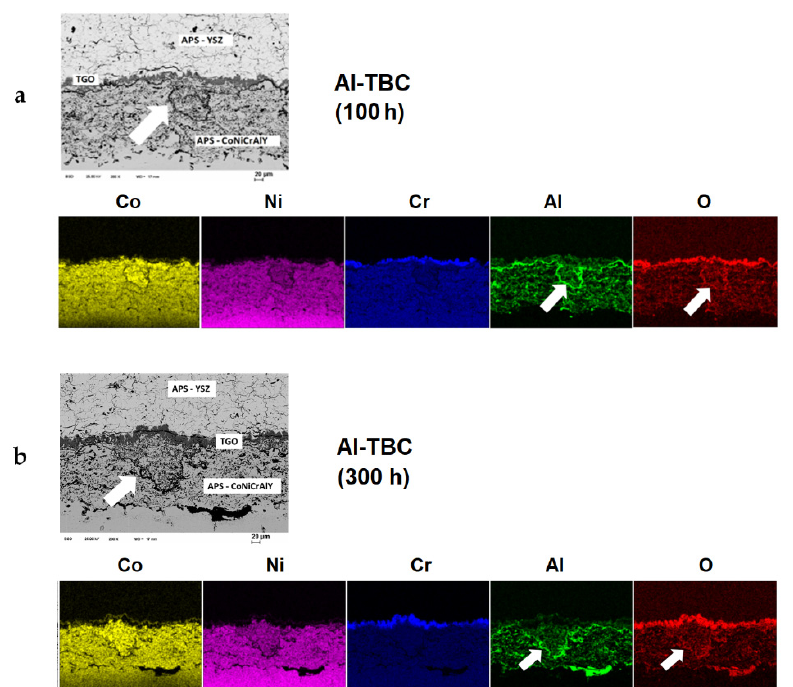
Figure 6. EDX mapping of the Al-TBC system after: ( a ) 100 h and ( b ) of 300 h of isothermal exposure; the arrows mark a dark line rich in “Al” and “O” along the BC microstructure and close to the BC/TC interface on the CoNiCrAlY BC side.